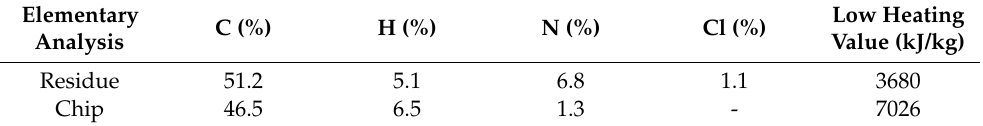
Table 1. Element analysis table.